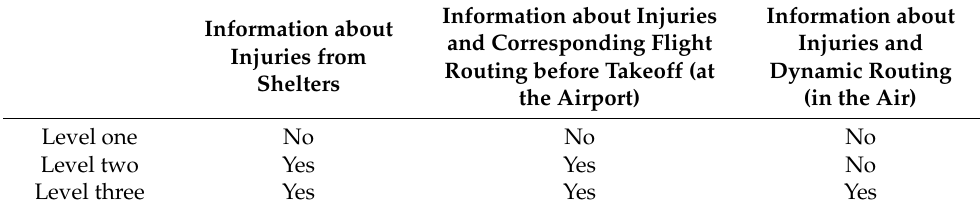
Figure 2. Information used in air relief activities. Table 1. Different levels of information sharing systems.